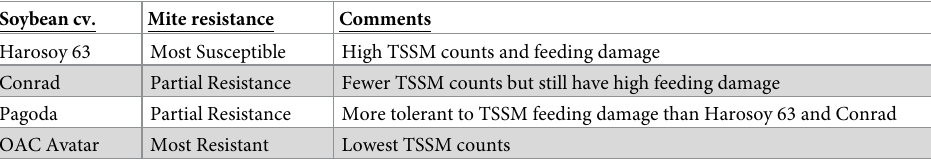
Table 3. Relative spider mite resistance ratings for 4 Ontario grown soybean cultivars. Soybean